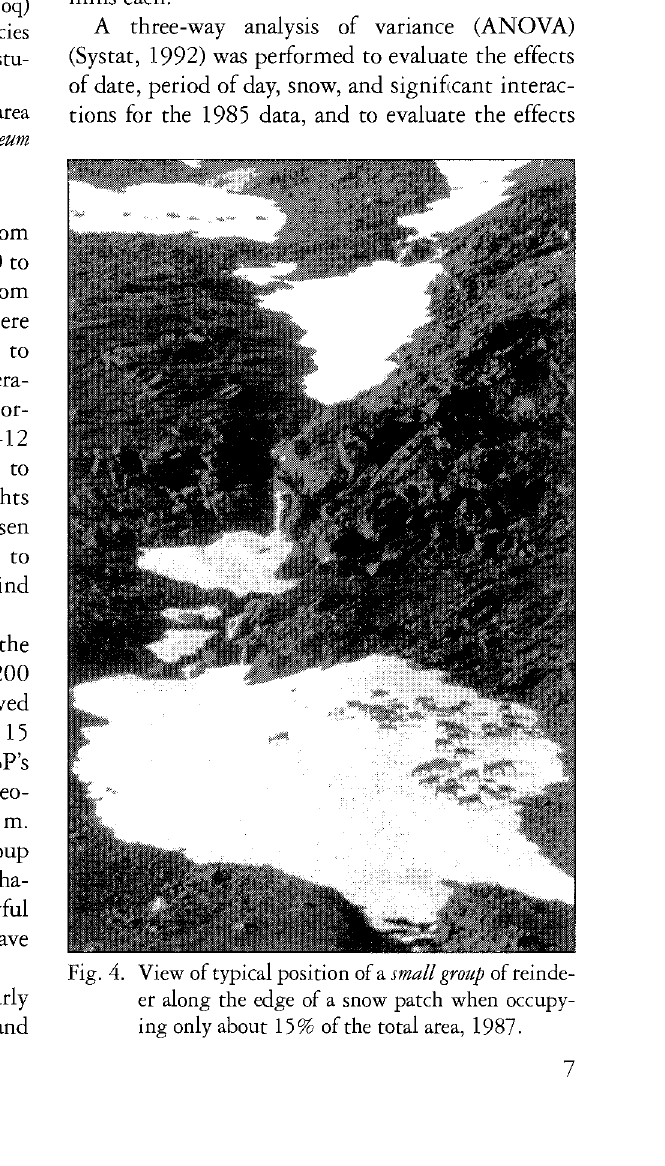
Fig. 4. View of typical position of a small group of reinde er along the edge of a snow patch when occupy ing only about 15% of the total area,